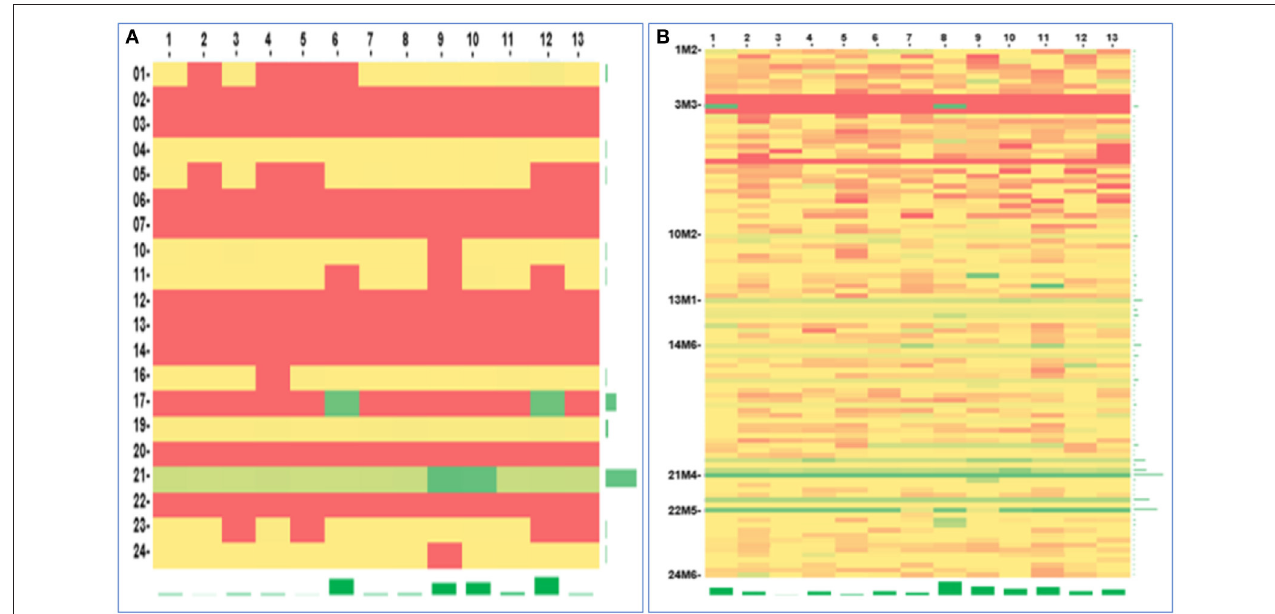
FIGURE 6 | Gene methylation analysis. The heatmap of the CDKN2A gene promotor methylation detected by two methods: (A) Routine sampling (methylation rate: 0–53.68%), (B) Multi-site tumour sampling (methylation rate: 0–100%). The horizontal axis described the CpG sites (The number 1–13 were corresponding to the aligned gene sequence sites of 1936, 1941, 1943, 1947, 1951, 1954, 1960, 1982, 1986, 1989, 2007, 2010, 2013, respectively), and the vertical axis described the samples. Red, yellow, and green represent low, medium, and high methylation rates,